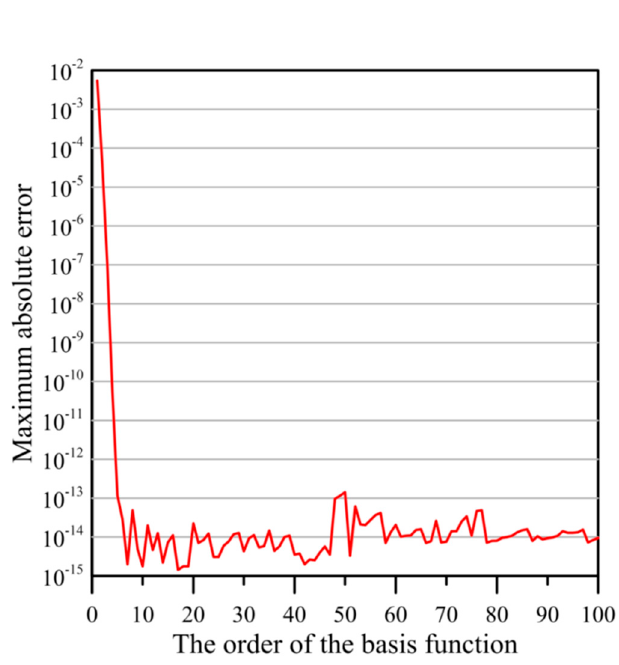
Figure 3. The basis function order versus the maximum absolute error (MAE).